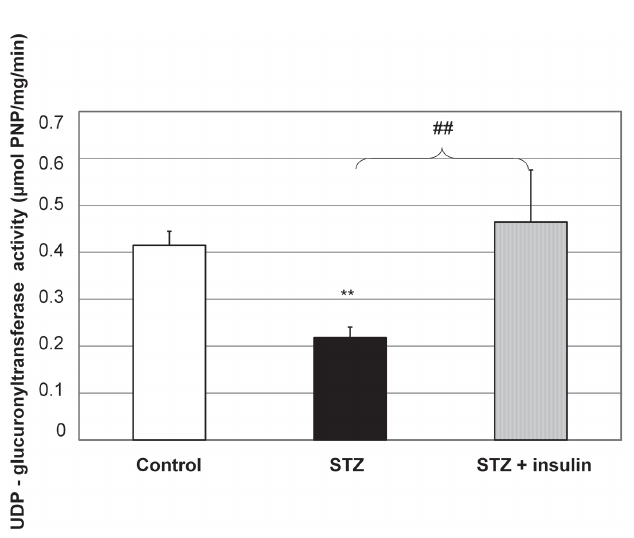
FIGURE 2 - Activity of UDP-glucuronyltransferase of the liver in control and diabetic rats without or with insulin administration. Values represent the mean ± S.E. of seven rats. Significant difference from the control value: ** p<0.01. Significant difference from the value of STZ-diabetic rats without insulin administration: ## p<0.01. The enzyme activity is expressed in μmol PNP/mg/min, which was conjugated in 1 minute calculated for 1 mg protein of the liver.